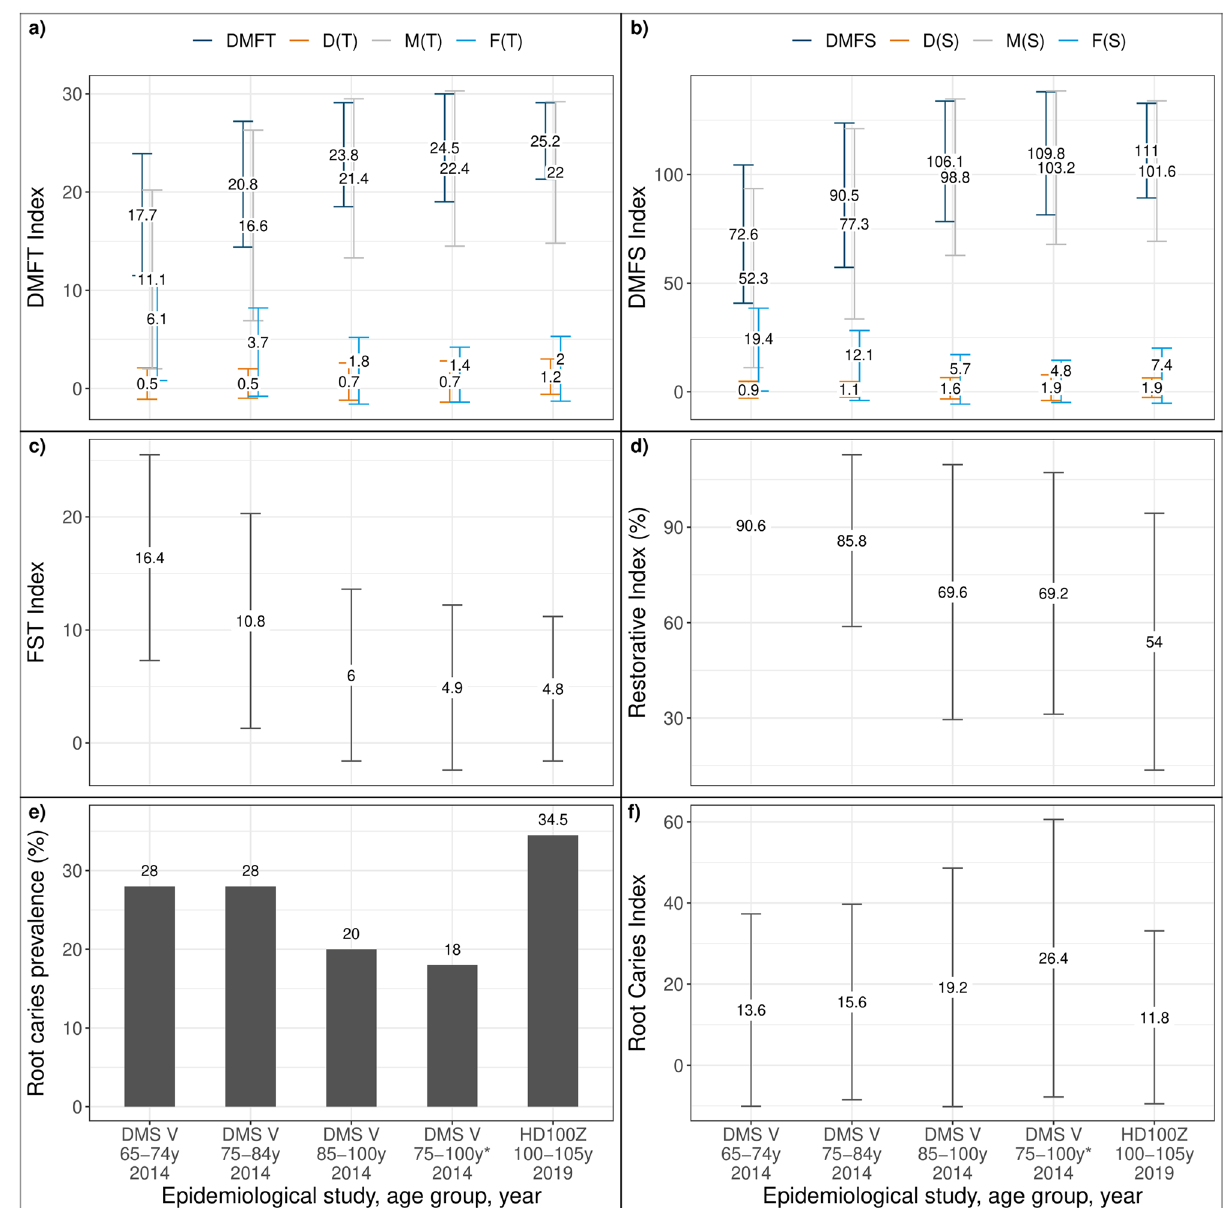
prevalence ( f ) Root Caries Index (standard deviation represented in bars if